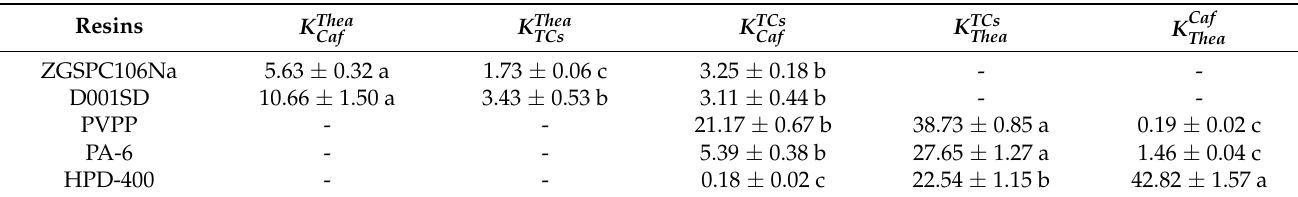
Figure 1. Adsorption of caffeine, catechins, L-theanine and tea polysaccharides onto the various adsorbents. TCs, total catechins; TPs, tea polysaccharides. Different letters (a–e) for each adsorbate indicated significantly different adsorption capacities between various adsorbents at p < 0.05. Table 1. Selectivity coefficients of various resins in a solution prepared from tea extract with a high level of